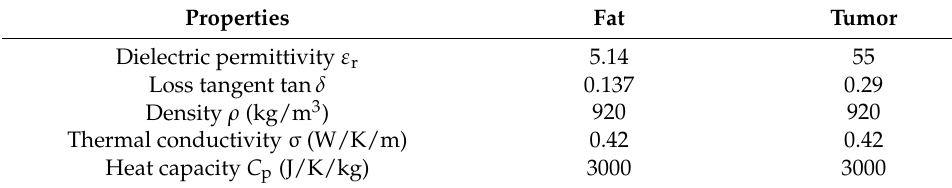
Table 1. Dielectric and thermal properties of breast tissues at 2.45 GHz